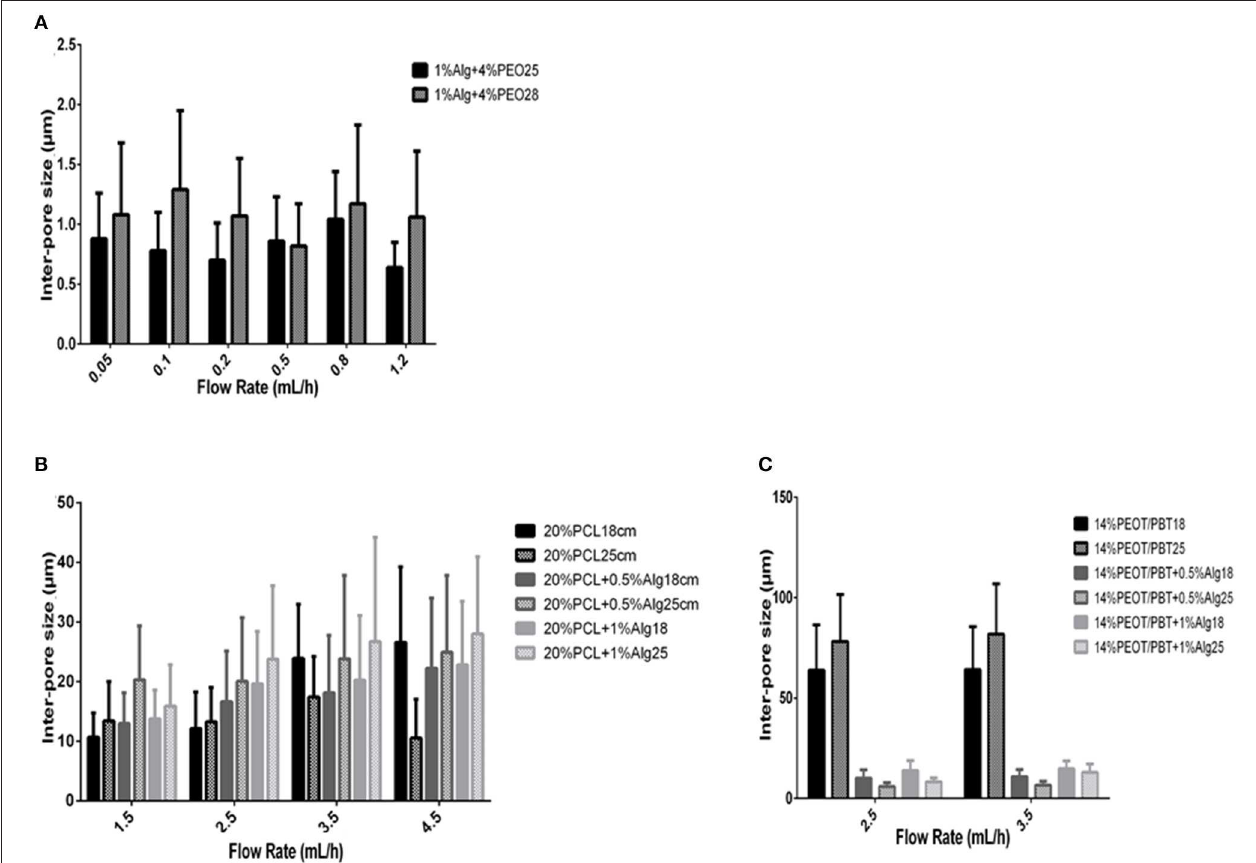
FIGURE 4 | Effect of the flow rate and air gap on inter-pore size of different materials. (A) Effect of the flow rate (0.05–1.2 mL/h) and air gap (25 and 28cm) on inter-pore size of Alginate/PEO blended electrospun scaffolds after crosslinking and washing with calcium chloride (1% Alginate + 4% PEO); (B) effect of the flow rate (1.5–4.5 mL/h) and air gap (18 and 25cm) on inter-pore size of PCL and PCL/Alginate blended electrospun scaffolds (20% PCL, 20% PCL + 0.5% Alginate, 20% PCL + 1% Alginate); (C) effect of the flow rate (1.5–4.5 mL/h) and air gap (18 and 25cm) on inter-pore size of PEOT/PBT and PEOT/PBT /Alginate blended electrospun scaffolds (14% PEOT/PBT, 14% PEOT/PBT + 0.5% Alginate, 14% PEOT/PBT + 1%